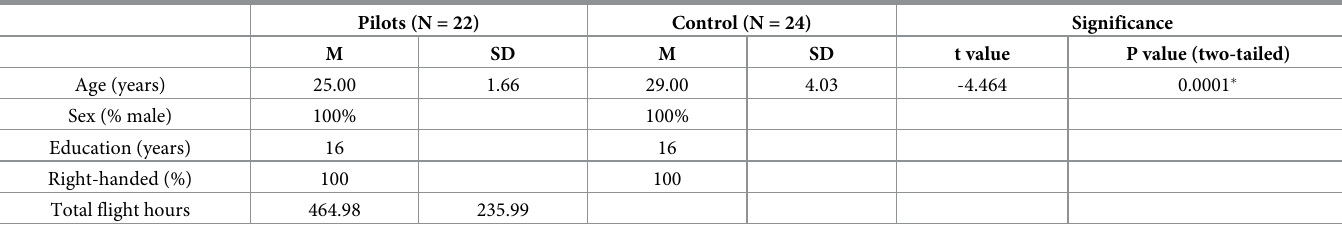
Table 3. Demographic